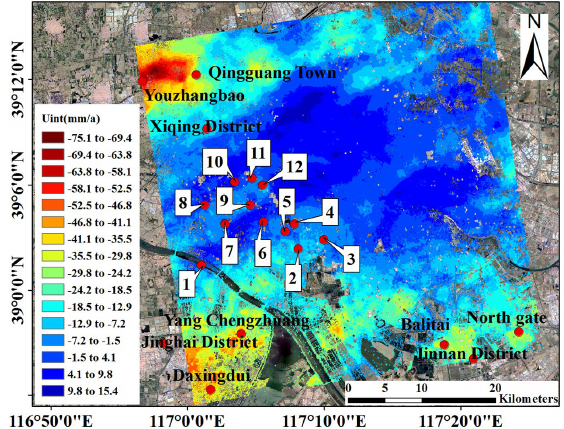
Figure 3. Ground vertical settlement rate in